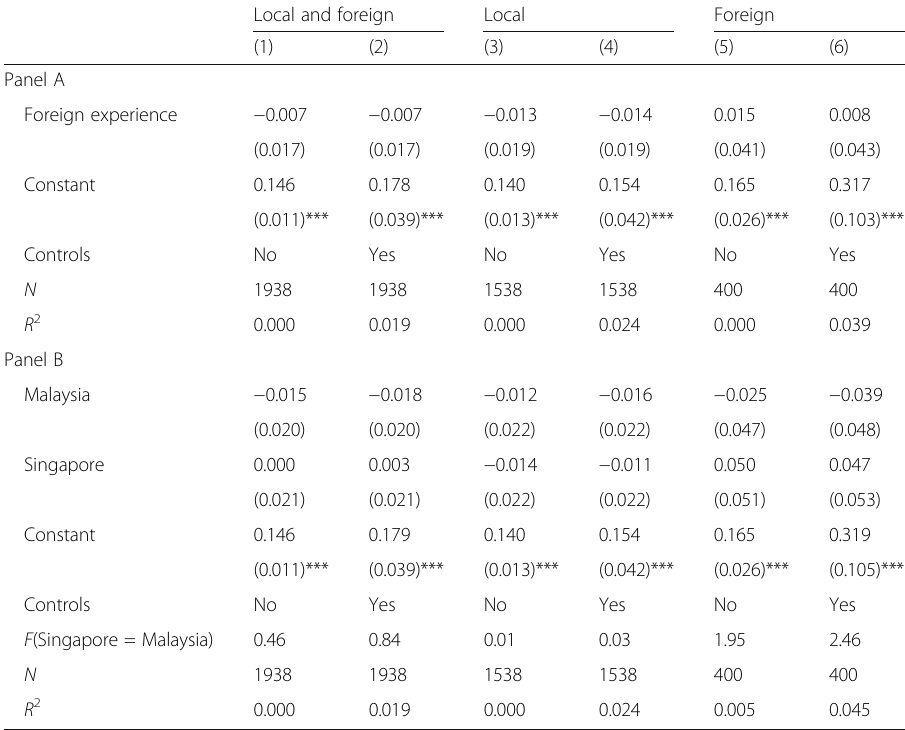
Table 3 Dependent variable: if a resume is the first to receive a callback for an interview (all occupations) Local and foreign